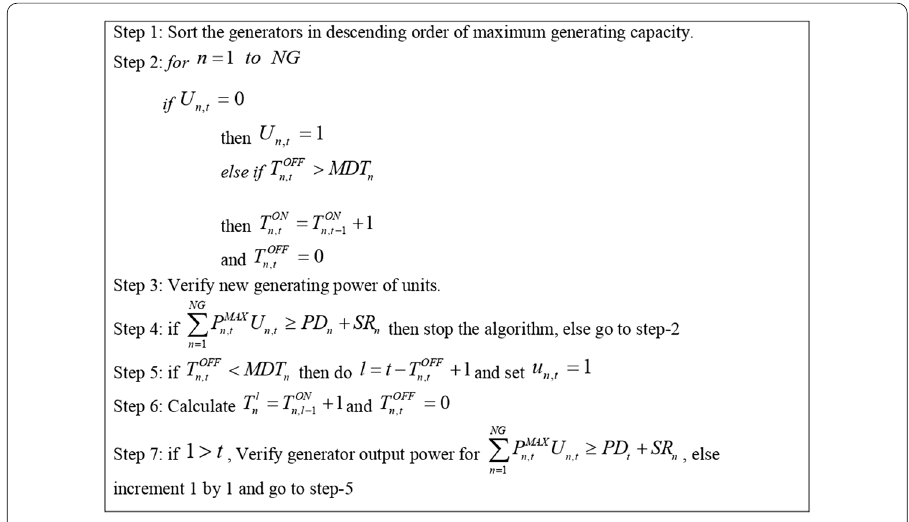
Fig. 1 PSEUDO code of SR